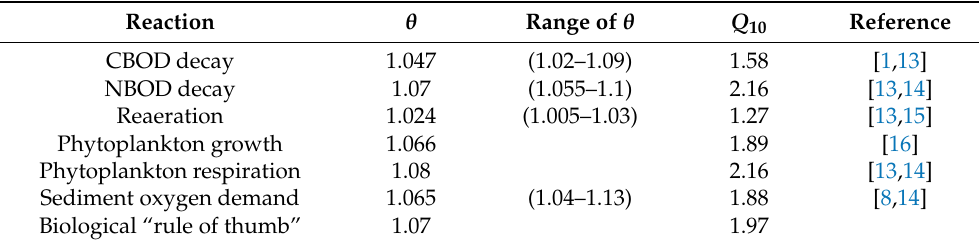
Table 3. Values of the temperature correction factors for the simple Arrhenius model for key reaction rates connected with dissolved oxygen levels in natural